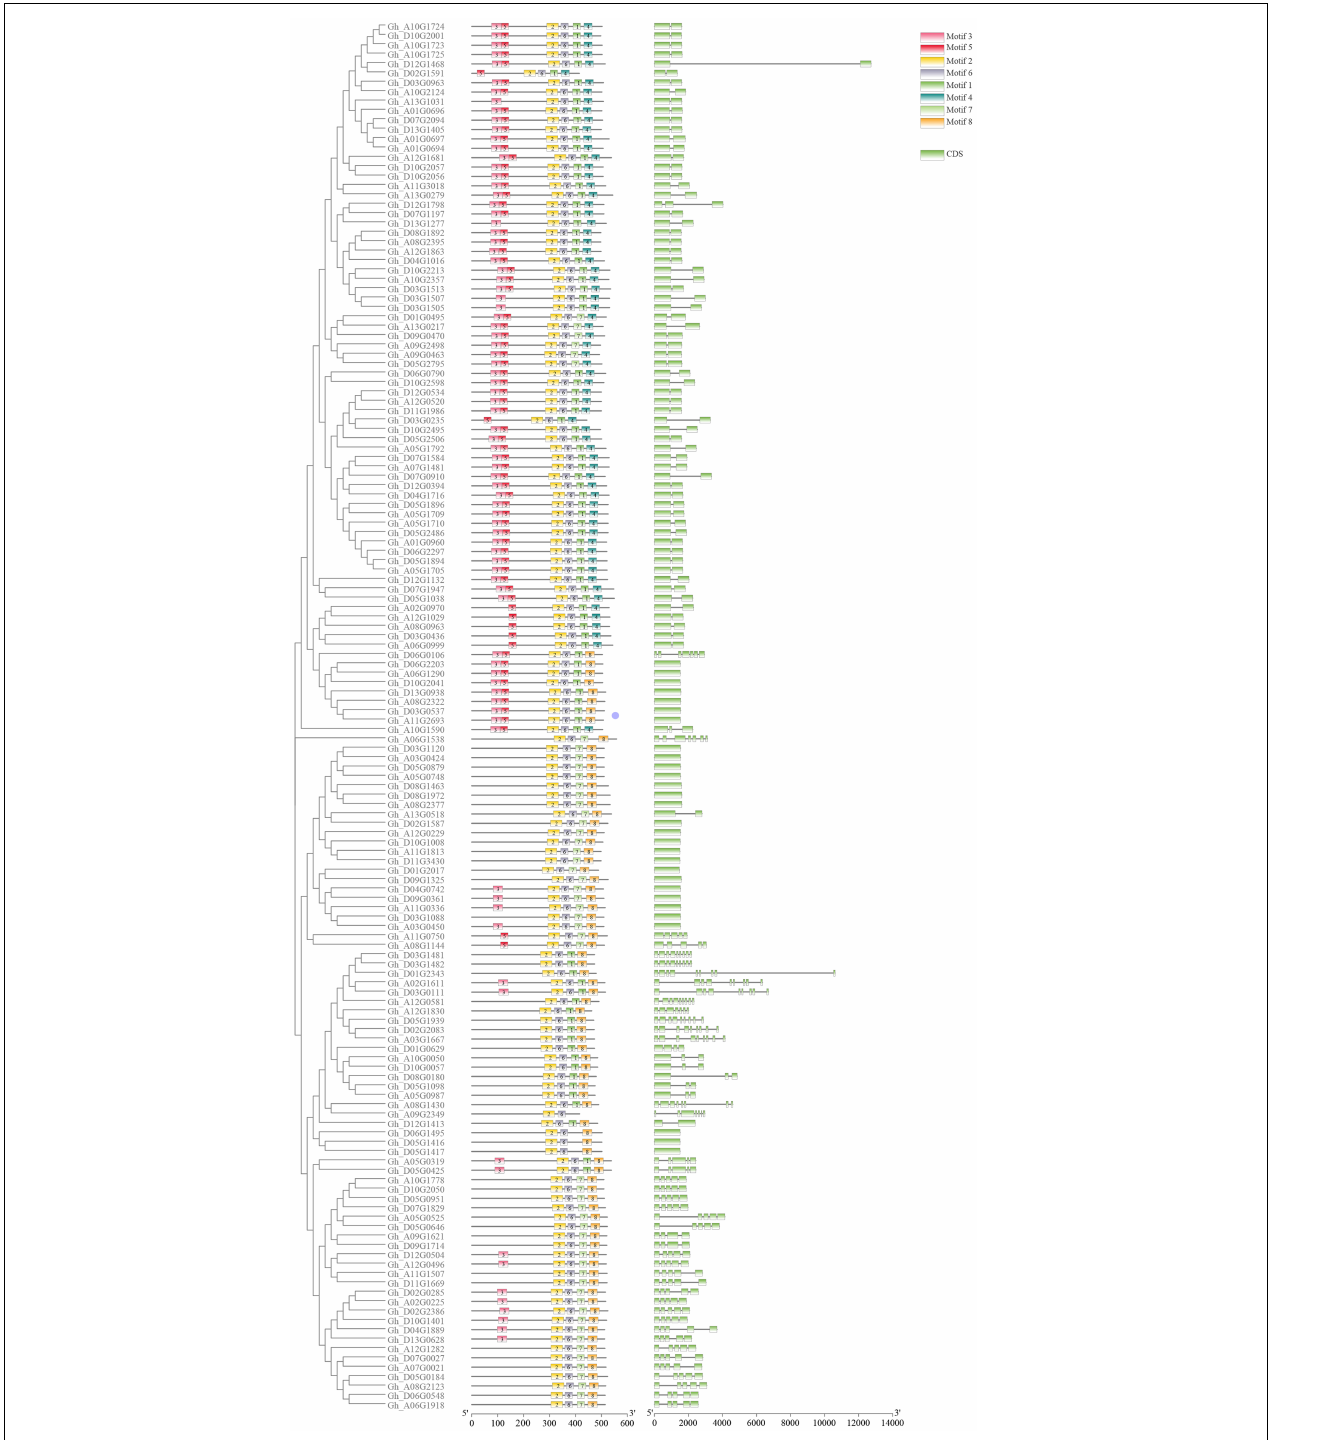
FIGURE 2 | Gene structure diagram of the P450 family in upland cotton. The three columns in the diagram are phylogenetic tree, motif, and exon in order from left to right.